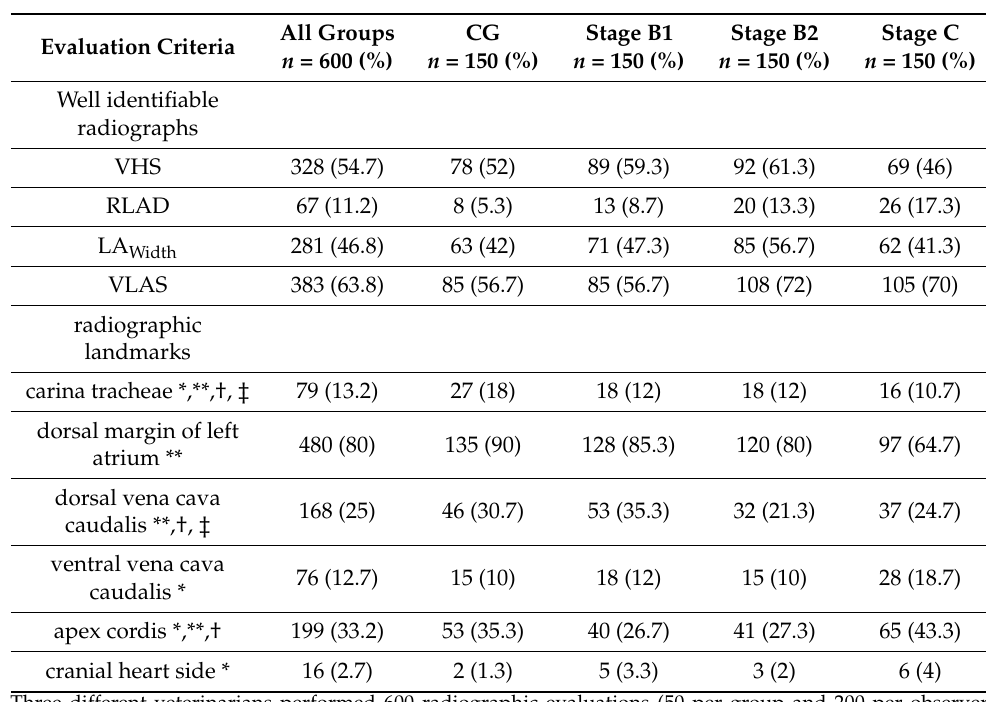
Table 5. Distribution of conventional well identifiable radiographs and radiographs with measure- ment difficulties in the different